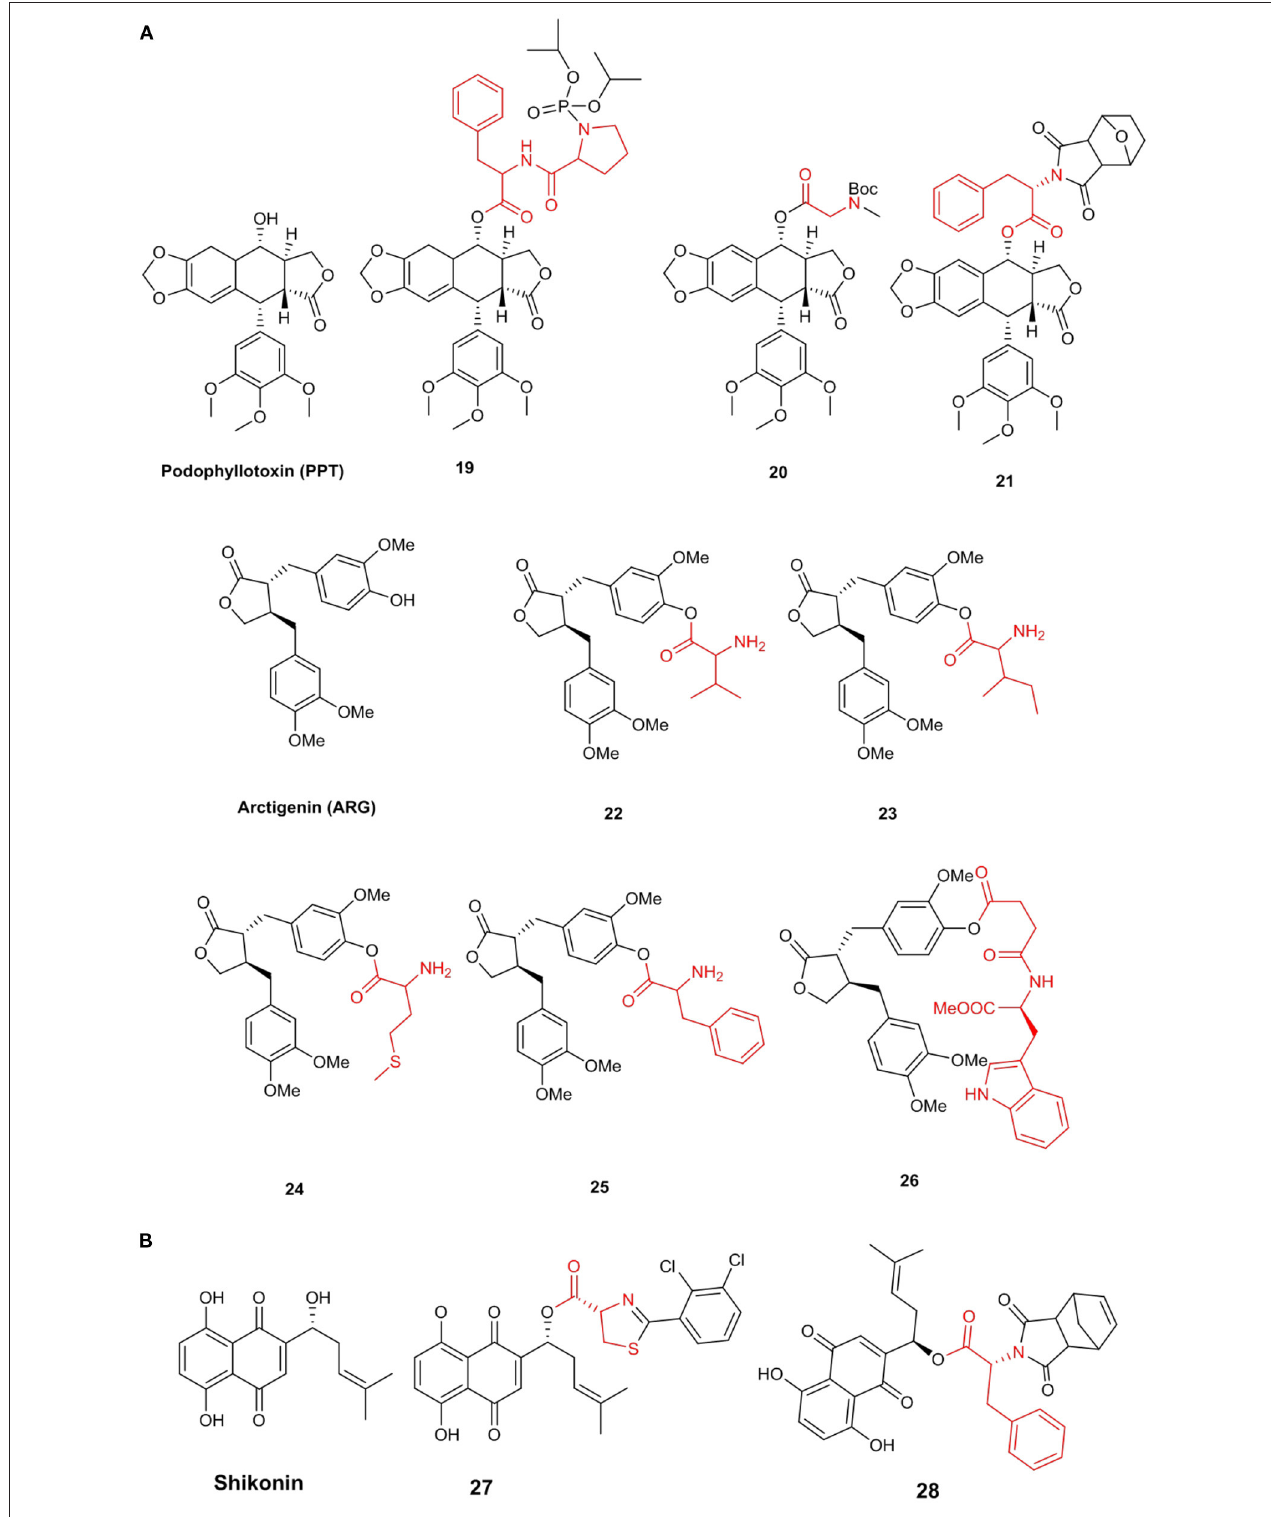
FIGURE 3 | (A) Lignans amino acid derivatives. (B) Shikonin amino acid derivatives.